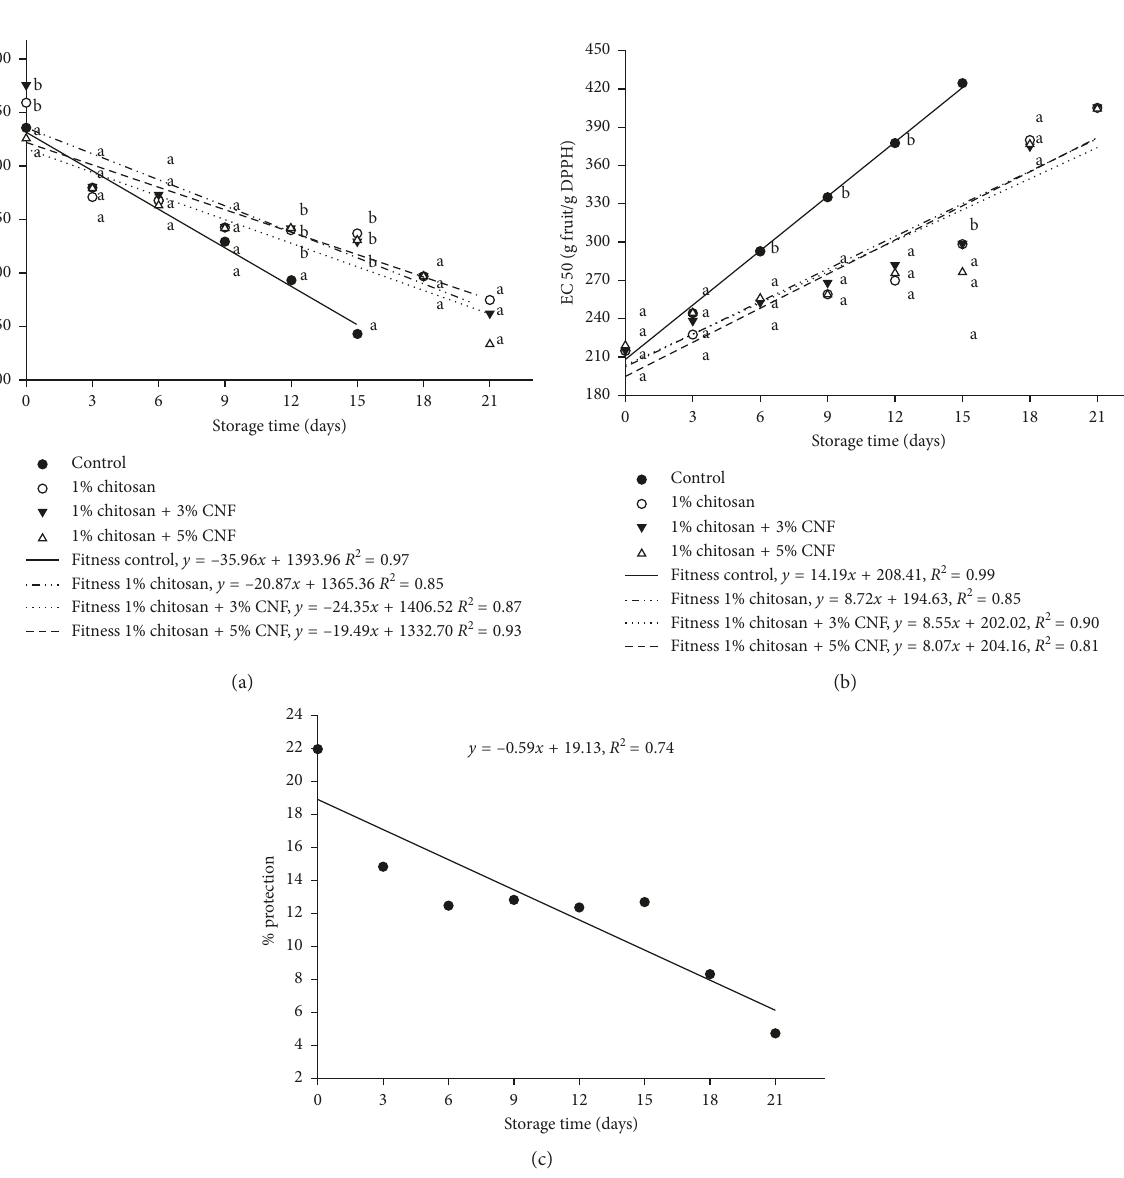
Figure 6: Strawberry antioxidant activity determined by the ABTS method (a), DPPH (EC50) method (b), and autoxidation of the beta- carotene/linoleic acid system method (c) for fruits with and without edible coating. Same letters in the same storage time denote that averages do not differ by the Tukey test at 5%